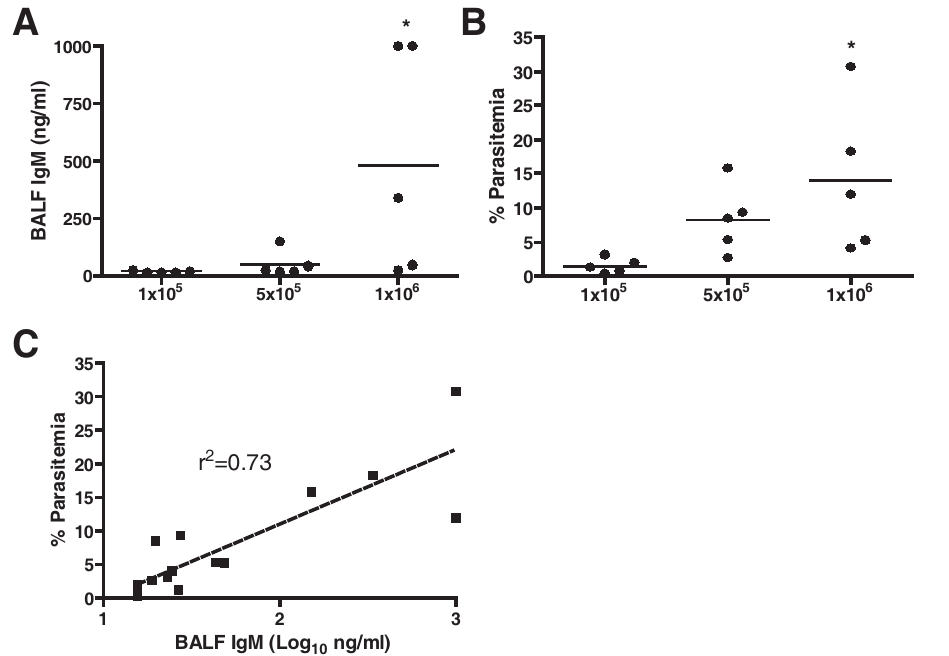
Figure 6. Parasite burden affects the development of ALI in PbA infection. To explore whether ALI was related to parasite burden, groups of C57BL/6 mice were inoculated with different doses of PbA, inducing a gradient of parasitemias within the same genetic background (n=6 mice/ dose (group)/experiment, representative of two independent experiments). A. BALF IgM was significantly increased at day 6 post-infection in C57BL/ 6 mice that received an inoculum of 1 6 10 6 PE compared to those receiving a dose of 1 6 10 5 (Kruskal-Wallis test with Dunn’s multiple comparison test, *1 6 10 6 vs. 1 6 10 5 PE: p , 0.05). B. An increased inoculum also corresponded with increased peripheral parasitemia at day 6 (Kruskal-Wallis test with Dunn’s multiple comparison test, *1 6 10 6 vs. 1 6 10 5 PE: p , 0.05). C. Parasitemia was positively correlated with log values of BALF IgM